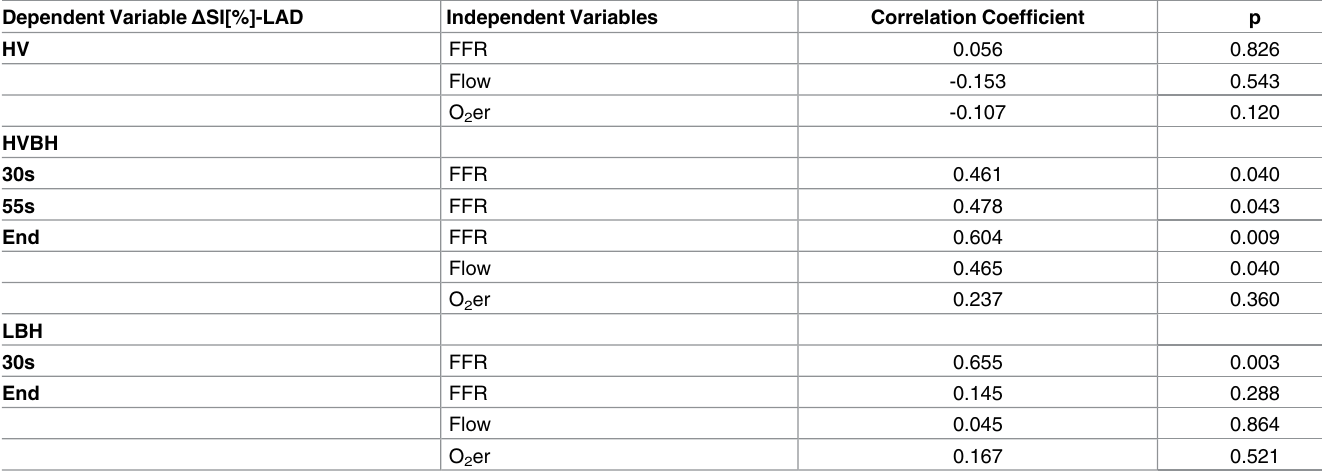
Table 2. Correlation of the regional oxygenation response to invasive